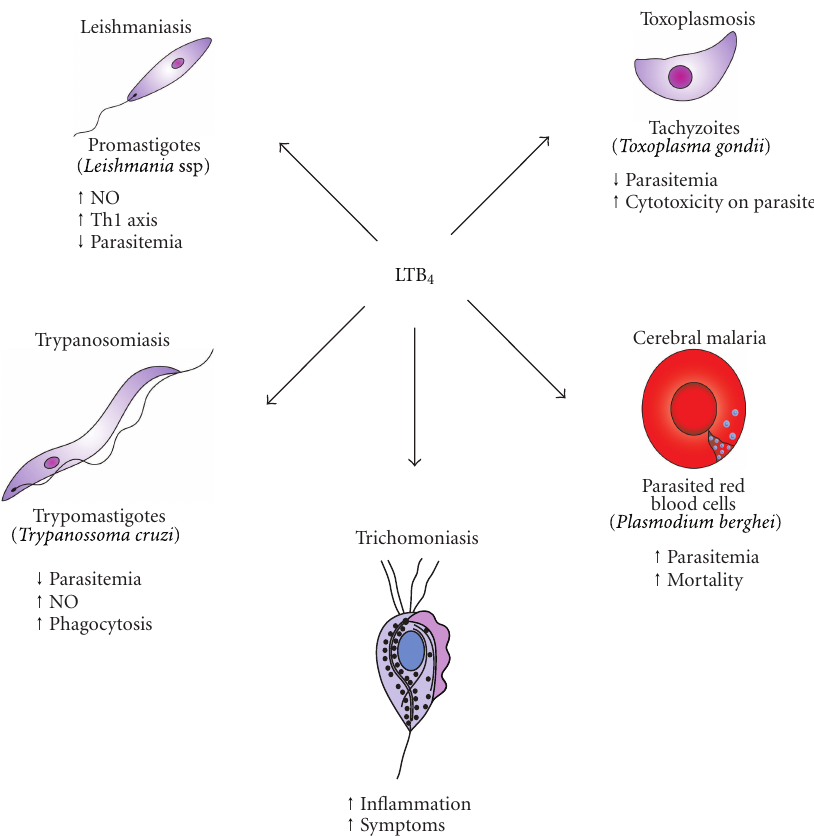
Figure 2: Roles of LTB 4 on protozoan infections. LTB 4 is involved in the control of leishmaniasis, toxoplasmosis, and trypanosomiasis. LTB 4 is also involved in the inflammation and symptoms of trichomoniasis. The overproduction of LTB 4 , after aspirin treatment, could be associated with the exacerbated pathogenesis of cerebral